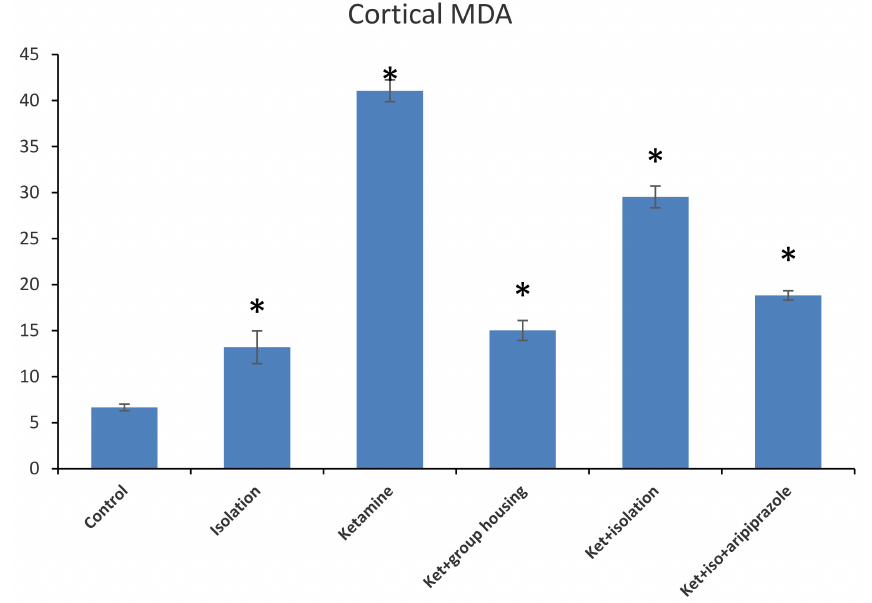
Figure 6. The effects of social isolation, ketamine, combined ketamine and social isolation, and combined ketamine, social isolation, and aripiprazole treatment on MDA-specific activity in cortex brain samples (measured in mmol/mg of protein). The values are mean ± SD ( n = 7 per group). * Significantly different when compared to control group ( p <